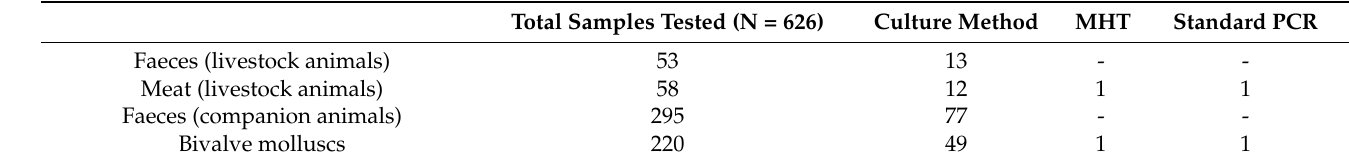
Table 1. Samples tested for carbapenem resistance by conventional methods (culture in ertapenem- enriched medium, MIC test, MHT, PCR). The number of analysed and positive samples for each test by sample type is reported in the table. Total Samples Tested (N = 626) Culture Method MHT Standard PCR